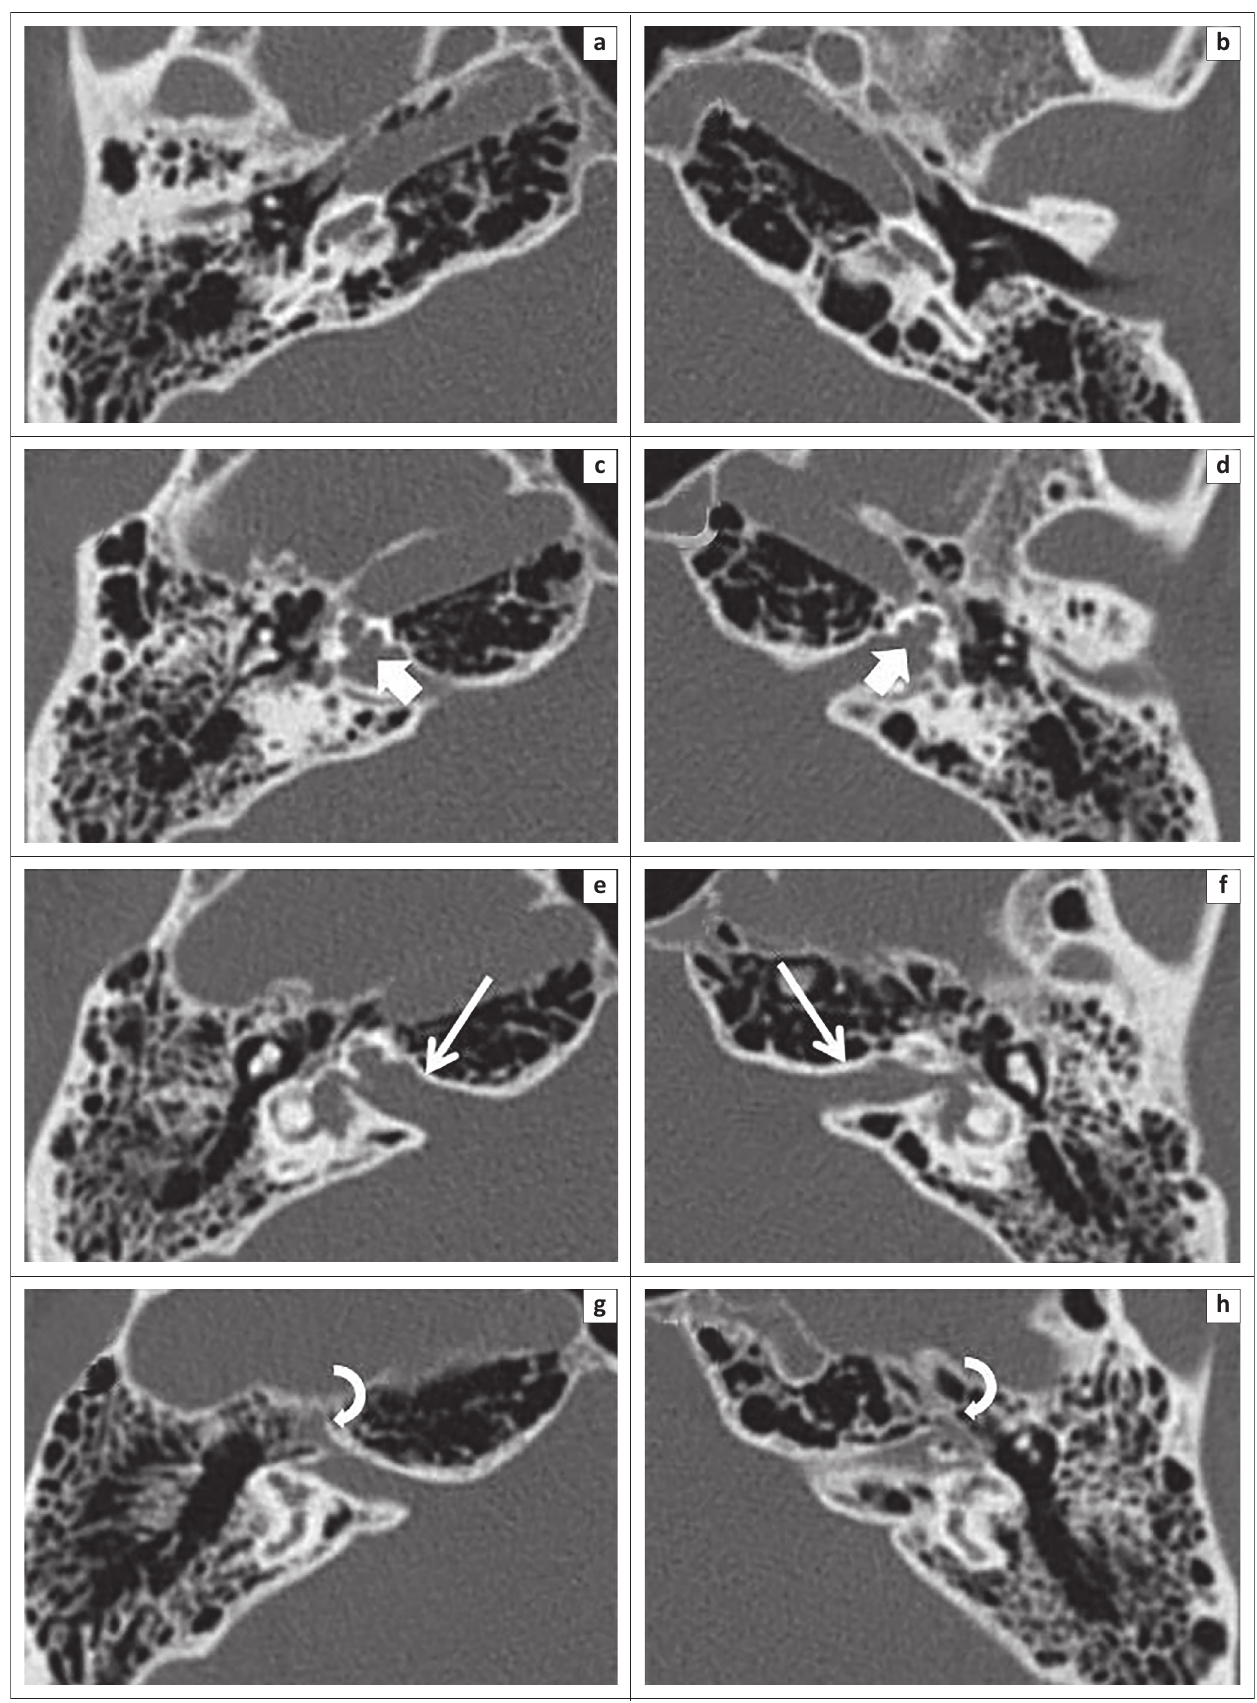
FIGURE 1: Axial images through the right (A, C, E and G) and left (B, D, F and H) petrous bone. Images show bilateral bulbous dilatation of the internal auditory canal (long thin arrows), absent modioli (short thick arrows) and dilatation of the labyrinthine segment of the facial canal on the right (curved arrow, G) and of the tympanic segment of the facial canal on the left (curved arrow,